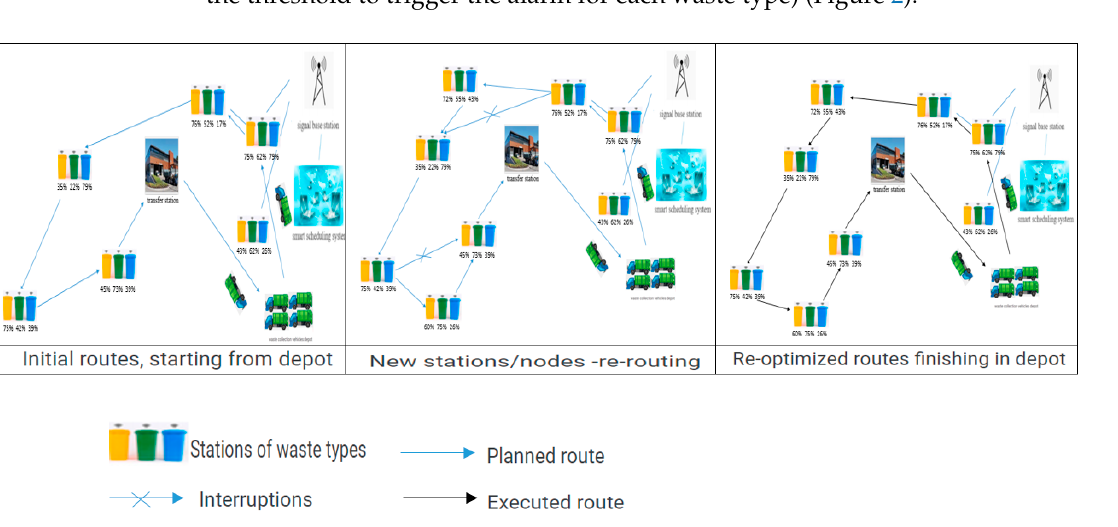
Figure 2. Fill level of each type in each station. Our problem can be defined as follows: given a set of n stations (each station contains 𝑚 (cid:3550) bins, and each bin is designated for a specific type of waste), a group of 𝑣 homoge- neous compartmentalized vehicles, a transfer station 𝑛 + 1 where vehicles unload differ- ent types of waste collected in the bins, and a depot (where all vehicles begin and complete their path), a complete undirected graph is defined over 𝑛 + 1 nodes, with distances 𝑑 (cid:3036)(cid:3037) for each edge (𝑖,𝑗) in the graph. Each bin of type w in station 𝑖 has a maximum ca- pacity 𝐶𝑝 (cid:3050) (in kg) . Let 𝐶 (cid:3036)(cid:3037) be the travel cost per unit of distance travelled. Each compart- ment in a vehicle has a capacity 𝐶𝑞 (cid:3040) (in kg). The sensors inside the bins transmit information on the bins’ fill levels in 𝑚 (cid:2871) , which is transformed into kilograms. To model and solve this problem, we will adopt the ap- proach proposed by [35], which consists of dividing the working day into time slices 𝑡 (cid:3036) (Figure 3); each time slice represents a partial static Multi-Compartment Vehicle Routing Problem (M-CVRP), which optimizes the route of each vehicle, where vehicles must serve all known stations at minimum cost while satisfying the capacity of the vehicle compart- ments, and the bins capacity. The discretization strategy we followed is different from that proposed in the litera- ture because we have stations that can be visited more than once in the same working day. The vehicle visits the stations that triggered the alarm, and collects the alarm types first. Then it contains the other waste types in the corresponding compartments if the capacity